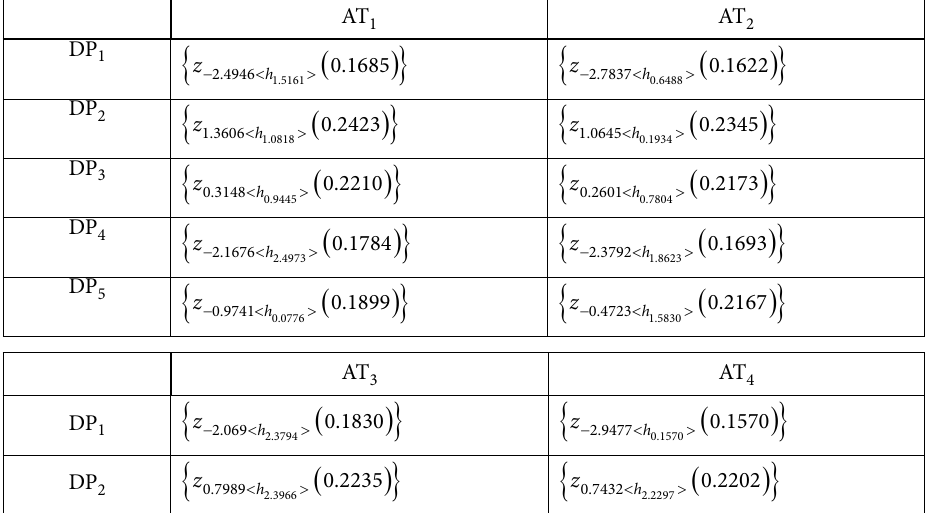
Table 13. The PDHLTSs decision information with prospects weight based on e 3 AT 1 AT